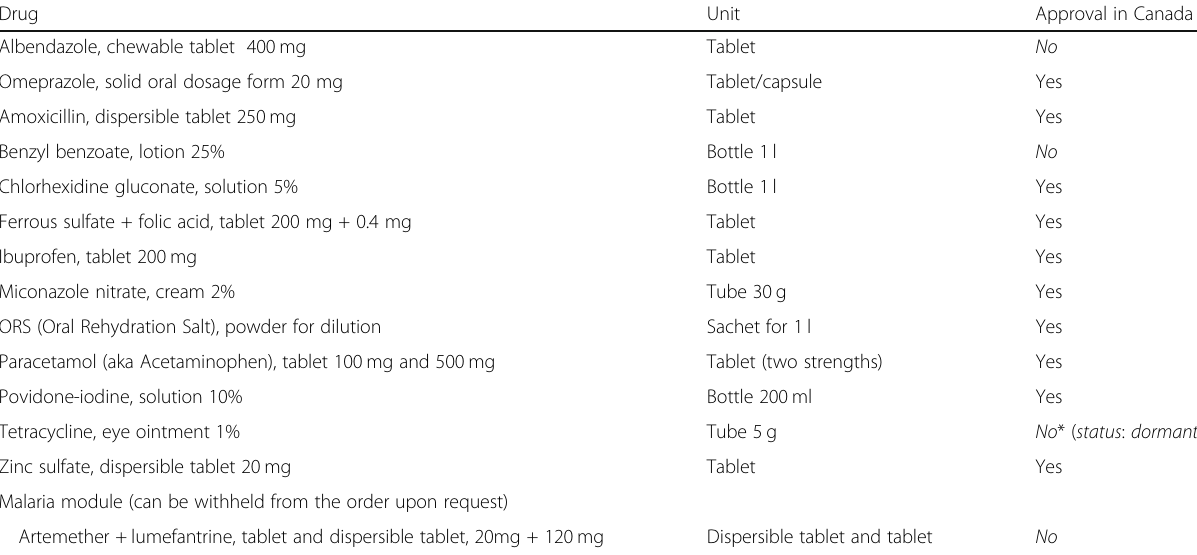
Table 1 Canadian approval status of Interagency Emergency Health Kit drugs Drug Unit Albendazole, chewable tablet 400